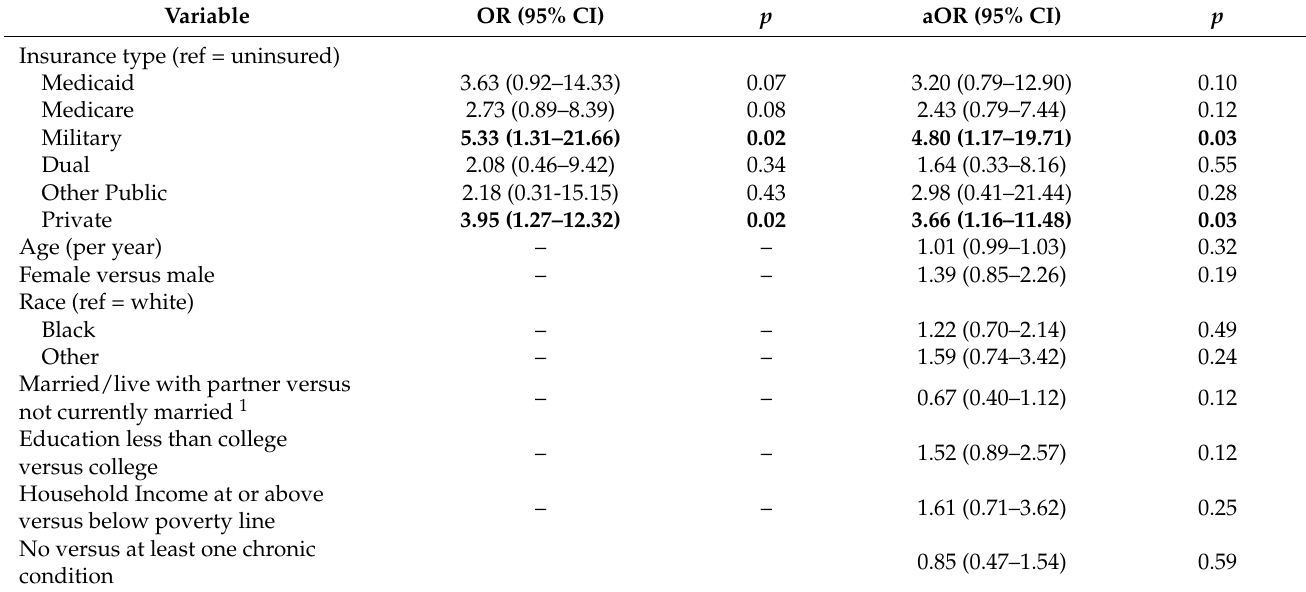
Table 3. Logistic Regression Evaluating Association Between Uptake of Genetic Testing/Counseling for Colorectal Cancer and Health Insurance Type for At-Risk